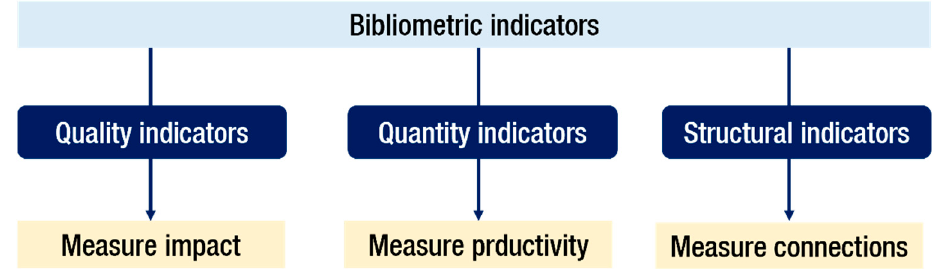
Figure 2. Types of bibliometric indicators.